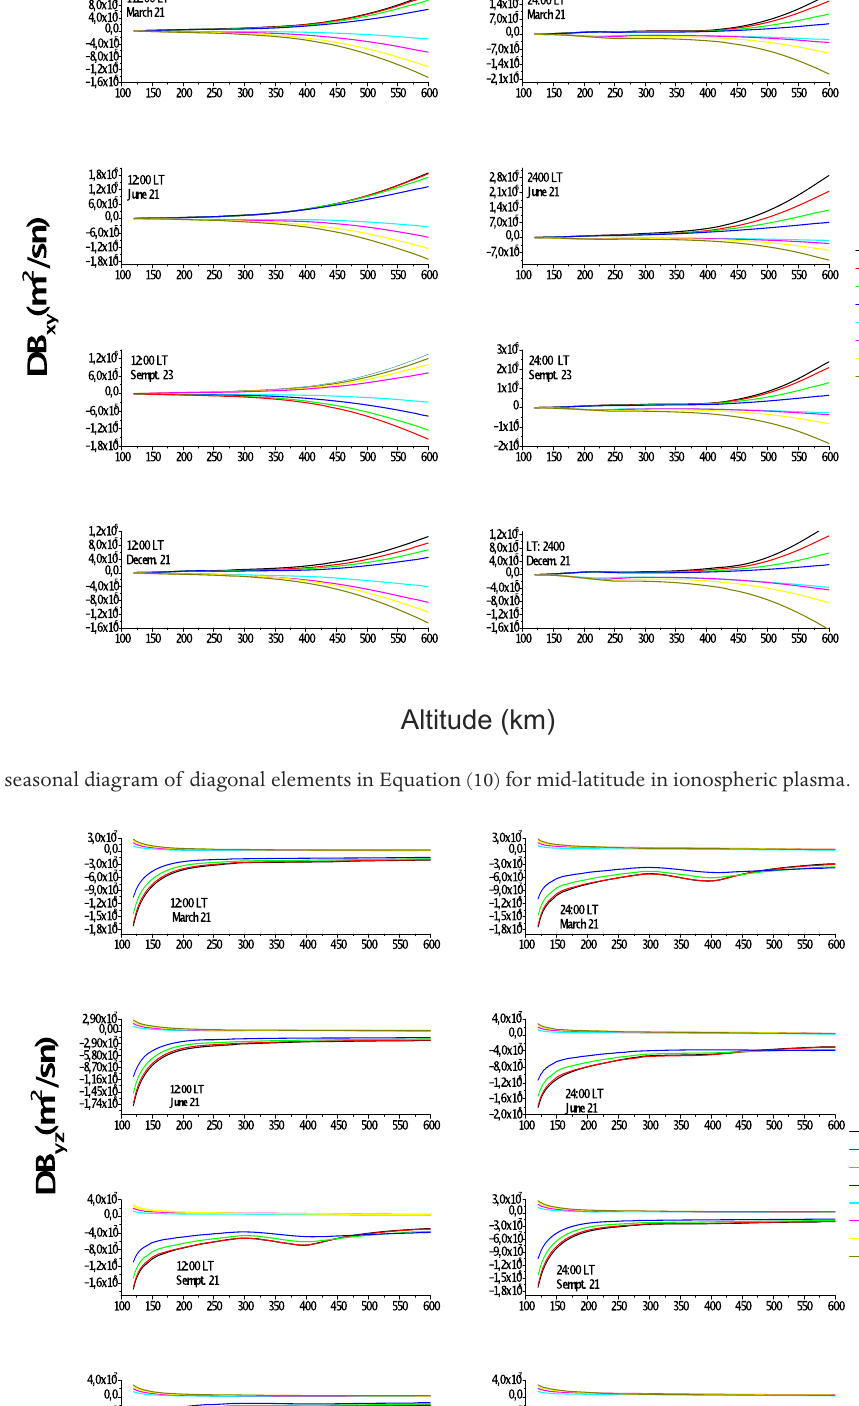
Figure 3. The seasonal diagram of DB